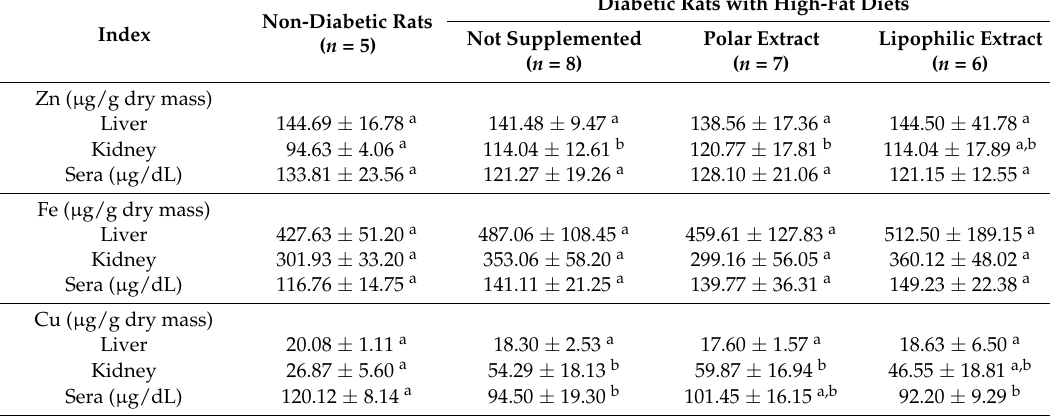
Table 7. Effects of dietary supplementation of elderberry polar and lipophilic extracts on the rats’ sera and tissular Zn, Fe and Cu levels. Diabetic rats without dietary supplementation and non-diabetic rats were also